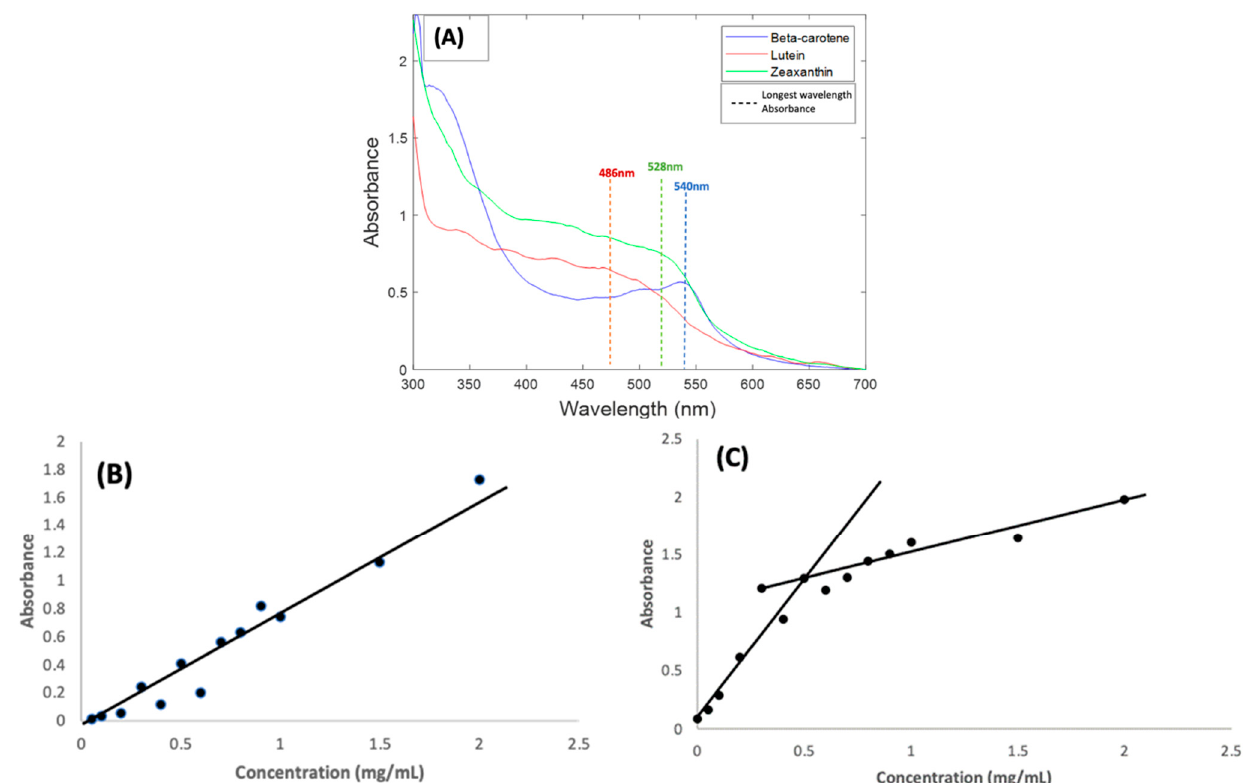
Figure 1. ( A ): Absorption spectra of 1 mg/mL BSA complexes of Beta Carotene, Lutein, and Zeaxan- thin solutions. The coloured lines indicate the approximate positioning of the longest wavelength absorption features ( B ): Concentration dependence of Beta Carotene/BSA complex solutions absorb- ance at 540 nm over the range 0.05 mg/mL–2.0 mg/mL. ( C ): Concentration dependence of Beta Car- otene/BSA complex solutions background at 700 nm.